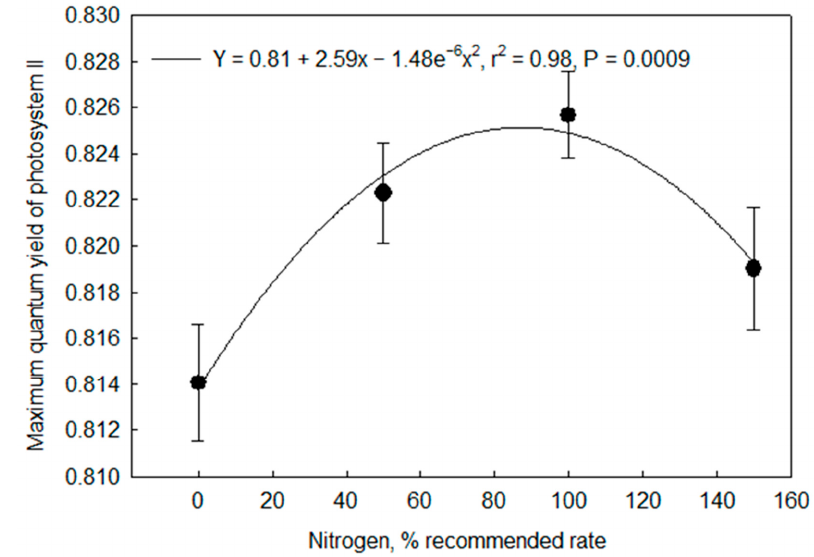
Figure 1. Nitrogen treatment effect on the maximum quantum yield of photosystem II of the first true leaf; F v / F m (FTL) of cotton. Data are means ± standard error ( n = 64 plantsin total for fourreplications and two runs).